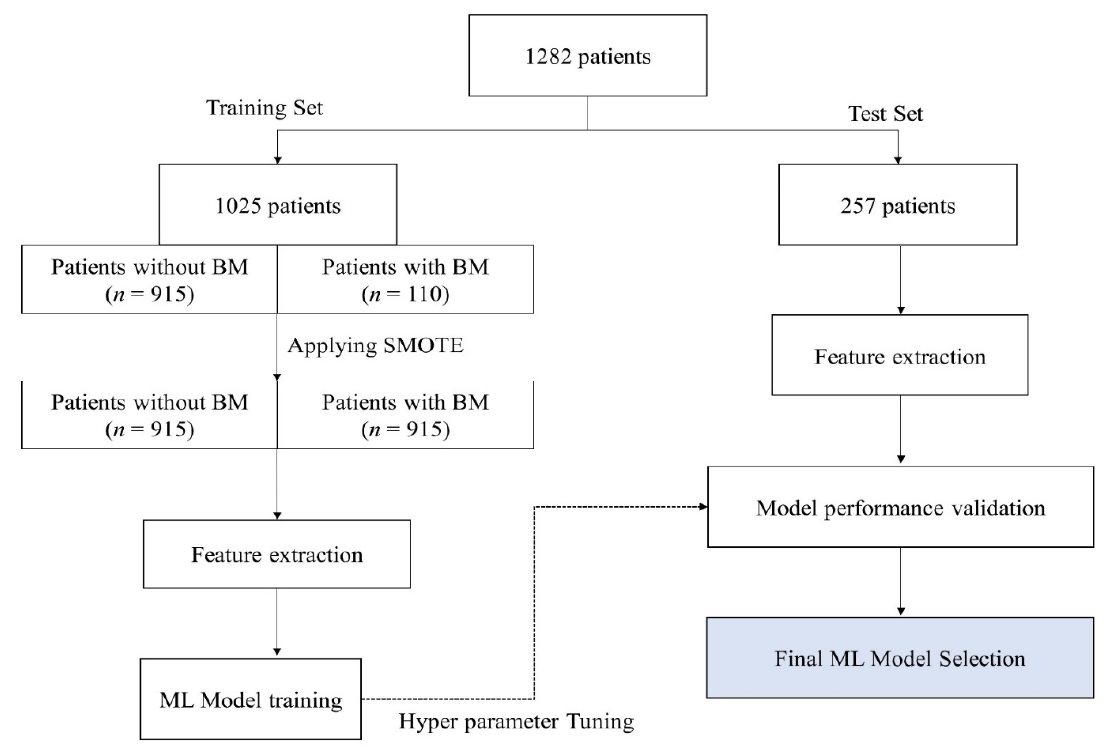
Figure 2. Machine learning (ML) modeling process.